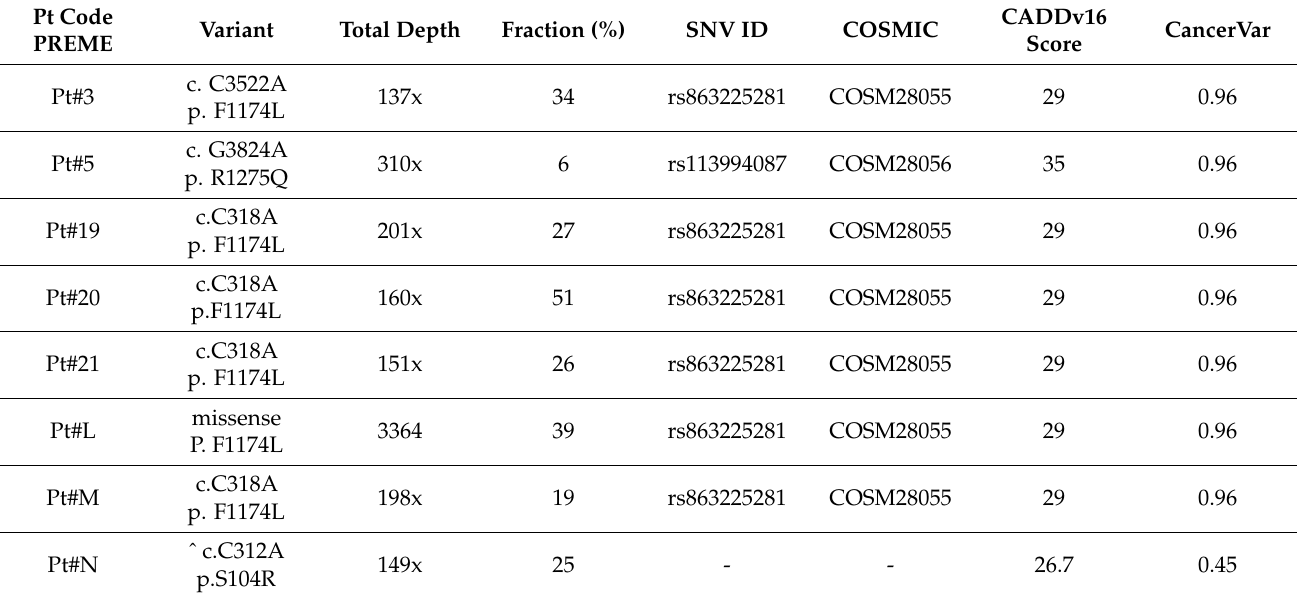
Table 2. Characteristics of patients: molecular profiling